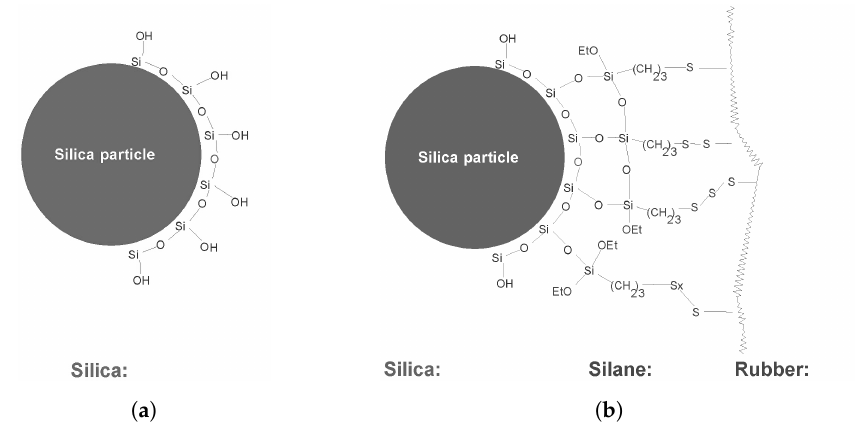
Figure 8. Chemical bonds between silica and rubber by silane bridges [18]. ( a ) Simplified schematics of the surface chemistry of silica. ( b ) Silane bridges between silica and rubber. Part of the silanol moieties are still unoccupied. Table 7. Compounding procedure for re-vulcanizate formulations with silane